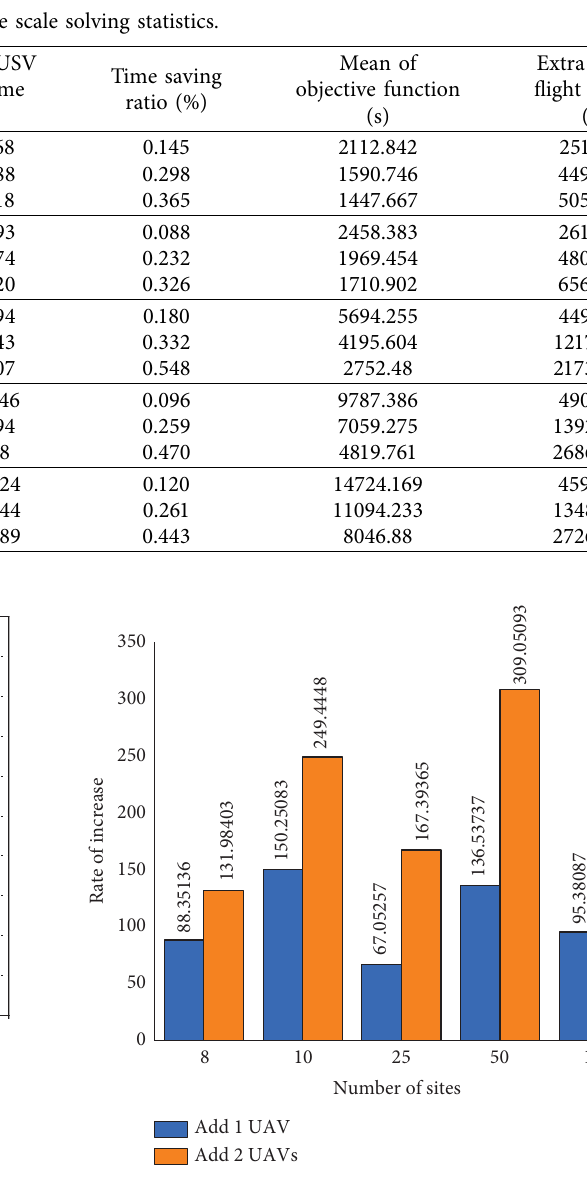
Figure 10: UAV time saving